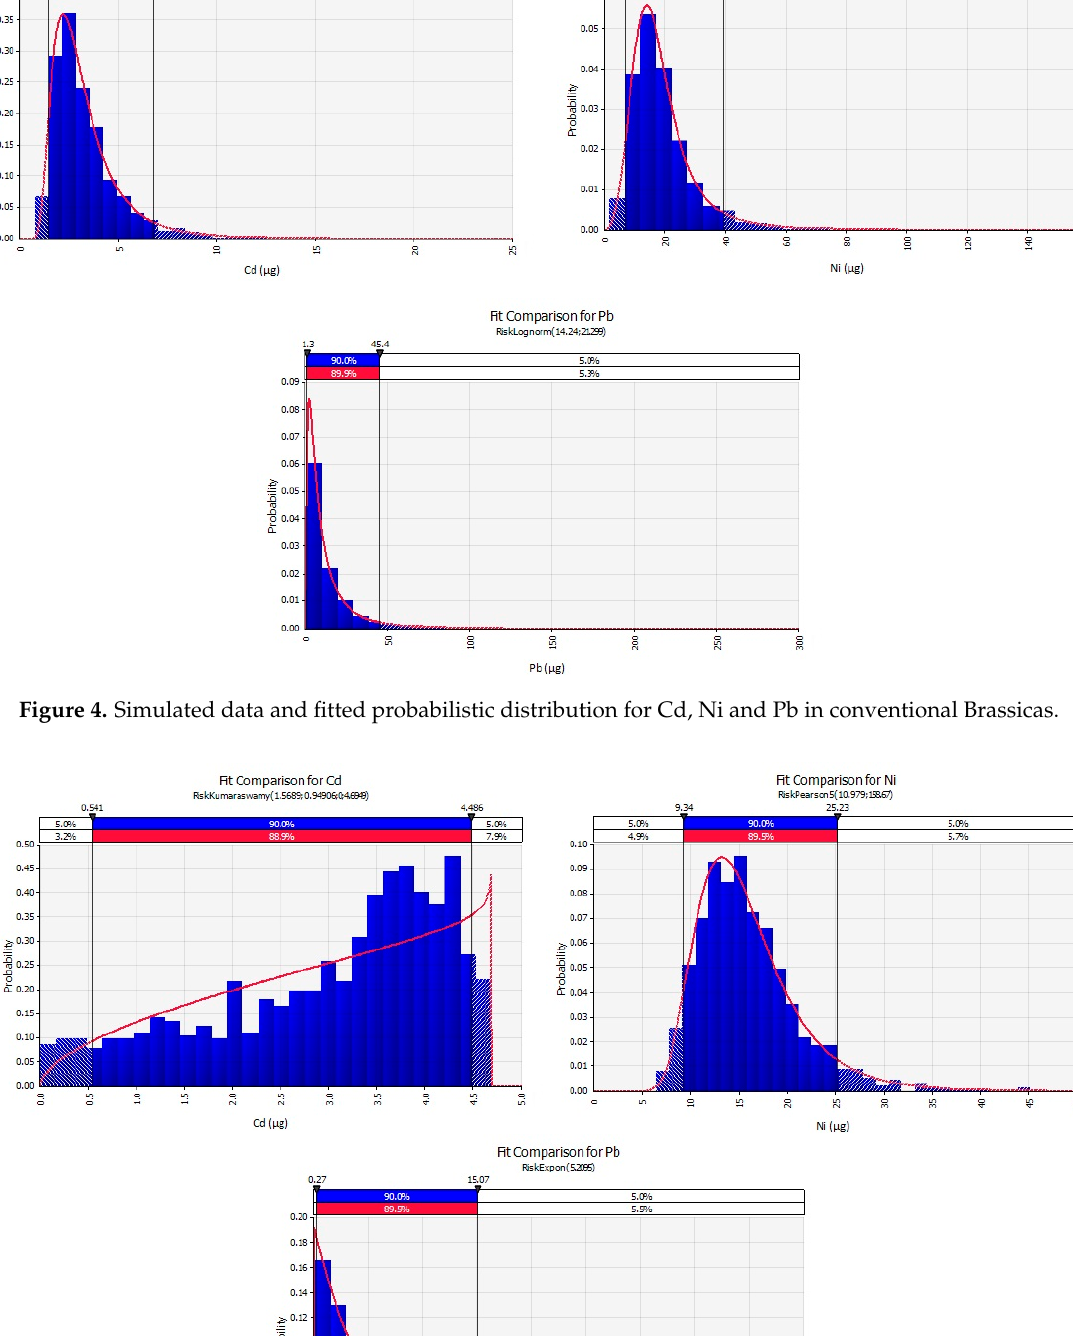
12 of 15 Figure 3. Simulated data and fitted probabilistic distribution for Co, Cr, Cu, Fe, Mn and Zn in organic Brassicas. Regarding heavy metals, we have considered intakes for 95th percentile as being the most unfavorable situation. Thus, Ni, Pb and Cd intakes for 95th percentile with con- ventional Brassicas were 39.00, 47.34 and 6.82 µg, respectively (Figure 4), whereas intakes with organic Brassicas were 25.70, 15.55 and 4.56 µg for Ni, Pb and Cd, respectively (Fig- ure 5). According to these values, organic Brassicas led to a decrease in the intake of these three elements metals. However, when these results were expressed as percentages of TI